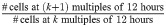
Drug-specific transition gains.For each treatment condition, values of the transition gains from the AM-optimized dynamics matrix are shown (units: #cellsat(k+1)multiplesof12hours#cellsatkmultiplesof12hours). Each transition gain from differentiation state i to differentiation state j of sufficient magnitude (ρij ≥ 0.10) is depicted as an arrow directed from i to j. Arrow style specifies gain magnitude. A dotted arrow means ρij ∈ [0.10, 0.30), a dashed arrow means ρij ∈ [0.30, 0.70), and a solid arrow means ρij ∈ [0.70, 1.00].